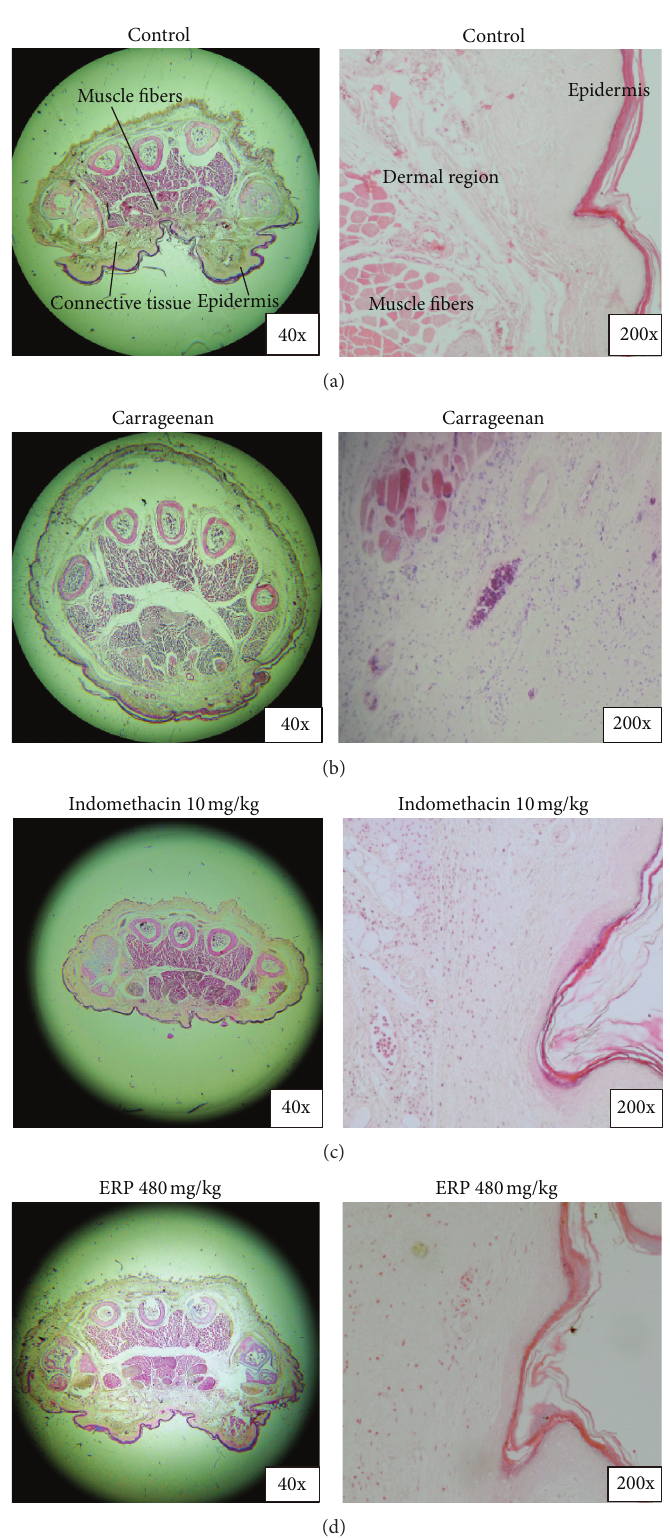
Figure 6: Histopathological examinations on carrageenan-induced paw tissue swelling, edema, haemorrhage, and leukocyte infiltration. (a) Control. (b) Carrageenan-control. (c) Indomethacin (10mg/kg). (d) ERP